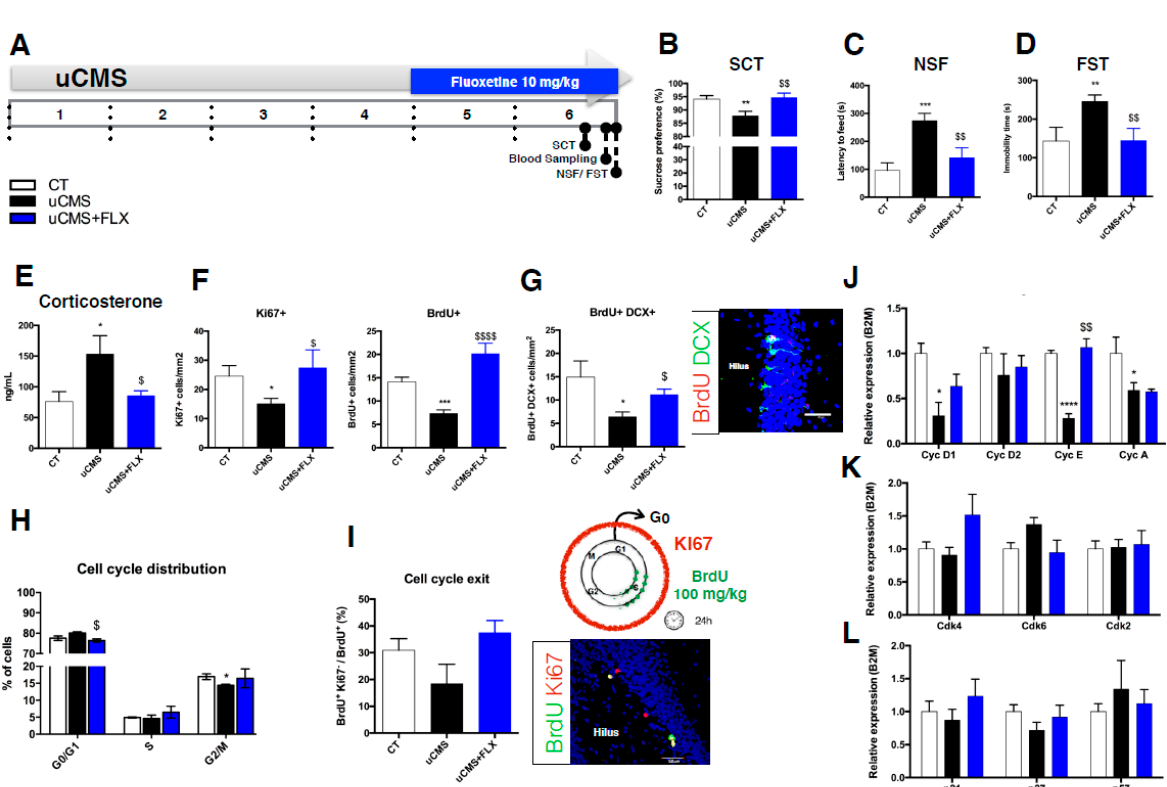
Figure 1. Cell cycle analysis in a uCMS animal model of depression. ( A ) Schematic representation of the experimental timeline used for the in vivo experiments. ( B – D) Behavioral characterization of the animal model of depression. uCMS exposure induced an anhedonic profile ( B ) as well as anxiety ( C ) and depressive-like behavior ( D ). These changes were reversed by treatment with fluoxetine. ( E ). Diurnal nadir corticosterone levels measured in the serum of the animals. ( F ) Ki67 and BrdU (injected 24 h before sacrifice) and immunostaining cell densities in the hippocampal DG. ( G ). Number of BrdU/DCX double-positive cells (cell densities) in the hDG and BrdU/DCX immunofluorescence (scale bar = 40 μ M). ( H ) Cell cycle distribution of hippocampal cells using PI staining and flow cytometry. ( I ). Cell cycle exit analysis using BrdU and KI67 immunostaining. Schematic representation of the BrdU administration paradigm and representative picture of the BrdU/Ki67 immunofluorescence in the DG. Scale bar = 50 μ M. ( J – L ) . Relative expression levels of G1 phase and S/G2 transition cyclins ( J ), CdKs ( K ), and Cdk inhibitors ( L ) in the hDG. Error bars denote SEM. * Denotes the effect of uCMS-exposure; $ denotes the effect of fluoxetine compared with untreated uCMS-exposed animals. * /$ p < 0.05; ** /$$ p < 0.01; *** p < 0.001; **** /$$$$ p < 0.0001. Abbreviations: CT: control; uCMS: unpredictable chronic mild stress; FLX: fluoxetine.